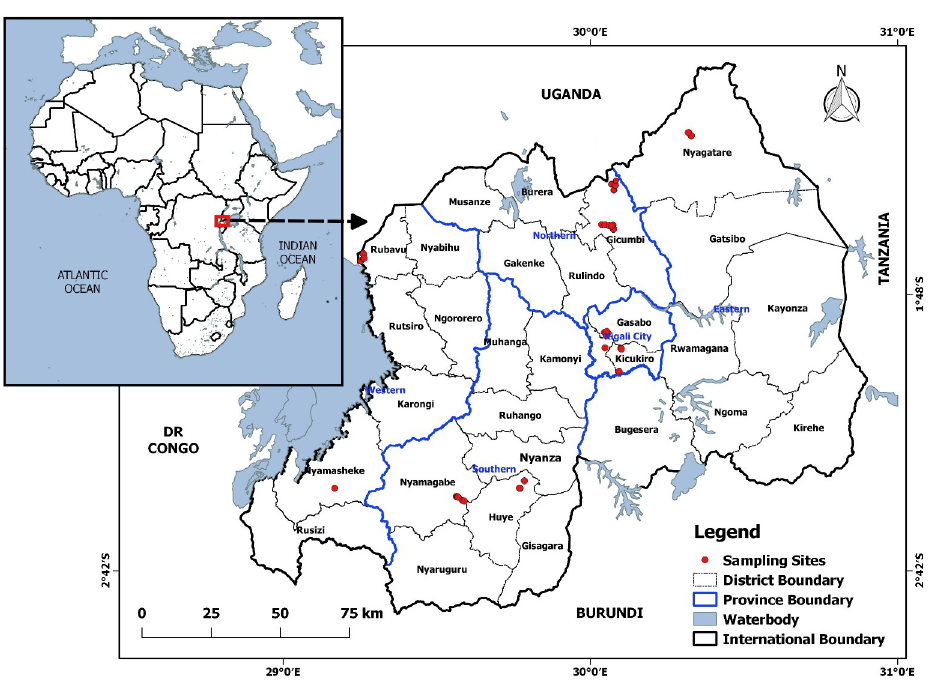
Fig 1. Map of sampling sites of chicken blood used in this